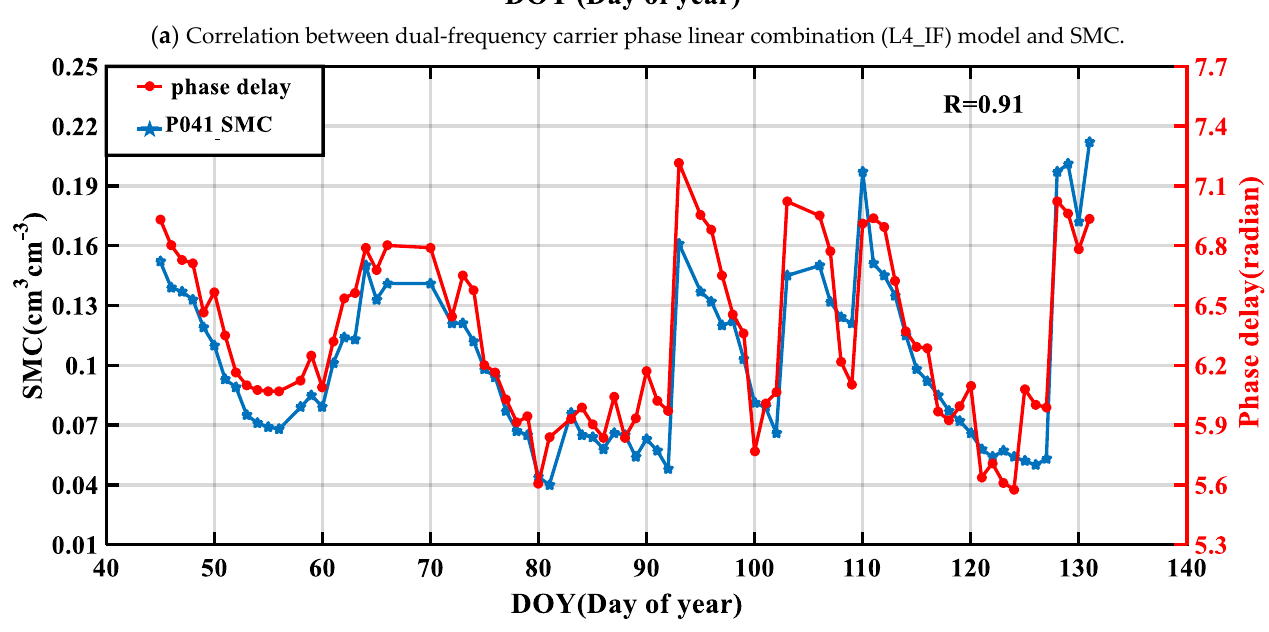
Figure 13. P041 station; correlation between Delay Phase and SMC. To further test the L4_IF method and the DFP method, 50 d of the P041 and MFLE SMC, respectively, and the estimated phase delay were employed to build an empirical model, and the other 28 d of data were used to verify the model. The modelling method employed was unary linear. In the relationship between soil moisture and phase delay, in this study, we used the phase delay as the independent variable (x) and the soil moisture as the dependent variable (y) to perform univariate linear regression modeling. We obtained the scatter plot and regression shown in Figure